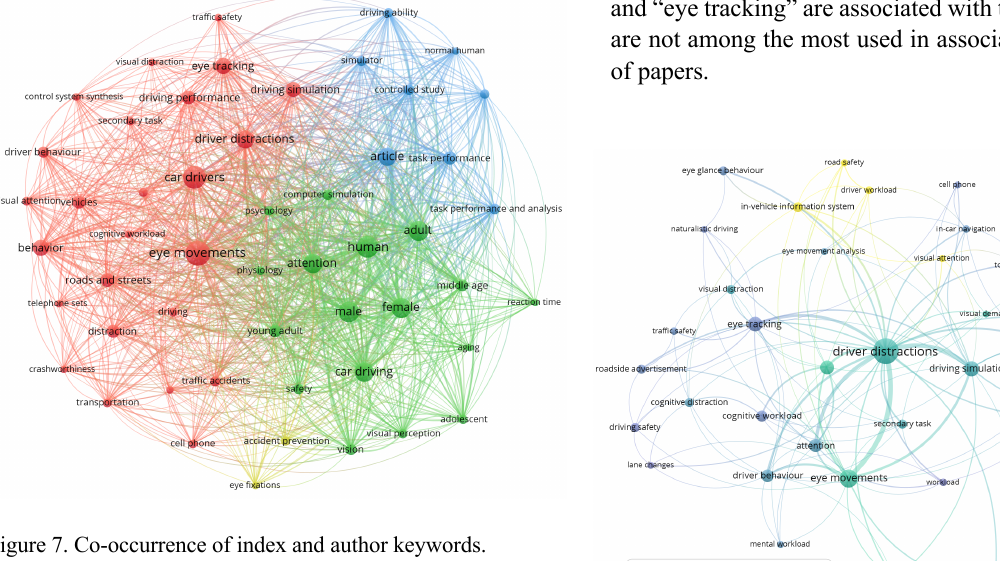
Figure 7. Co-occurrence of index and author keywords.